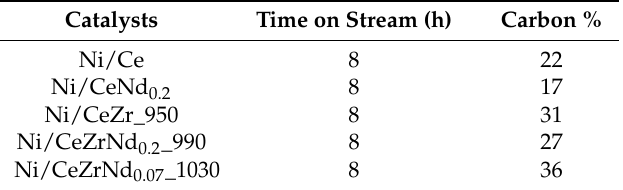
Table 4. Amount of carbon formed after durability tests at 650 ◦ C via TGA